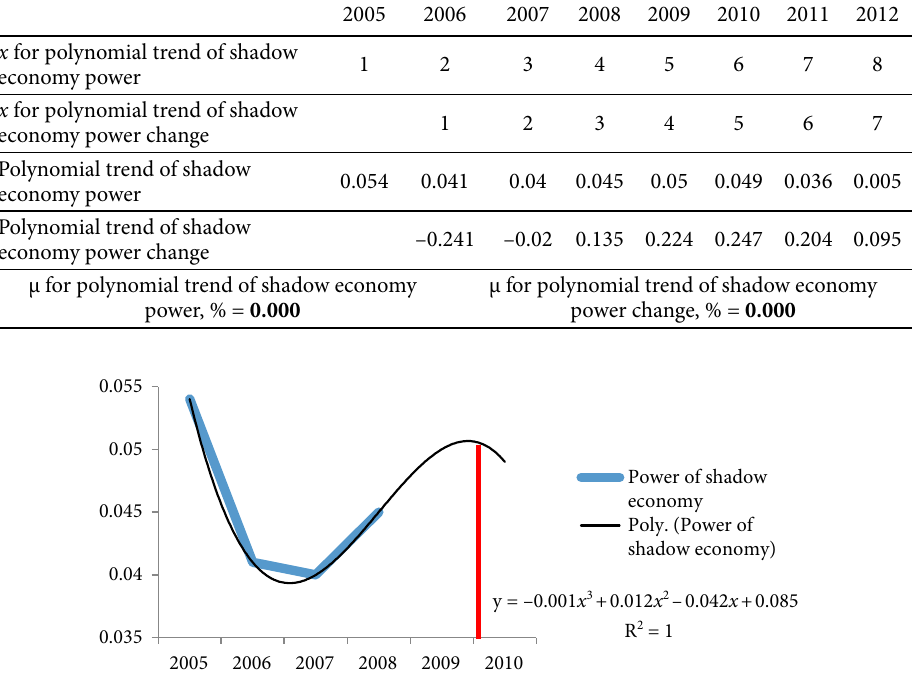
Fig. 3. Dynamics of shadow economy power up through 2008 in Lithuania and its trend The prognostic model obtained on the basis of the shadow economy power growth rate – V )/V ) also indicates a break in the shadow economy’s power in 2010. This (GR = (V present past past coincides with the real fact (Fig. 1). Besides this, the visual fact is also confirmed by a bias = 0.000%), which allows the statement that the estimated of approximation close to 0 (μ poly variable can be used for the prediction of the macroeconomic situation (Fig. 4).